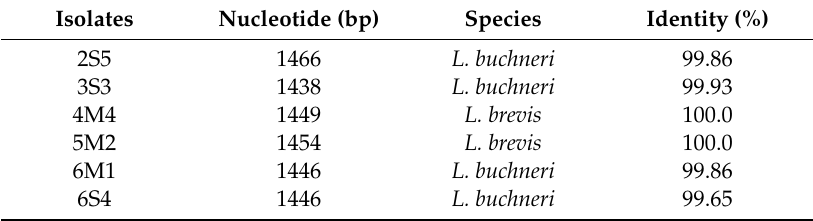
Table 2. The identifications of LAB isolates using 16S rRNA gene